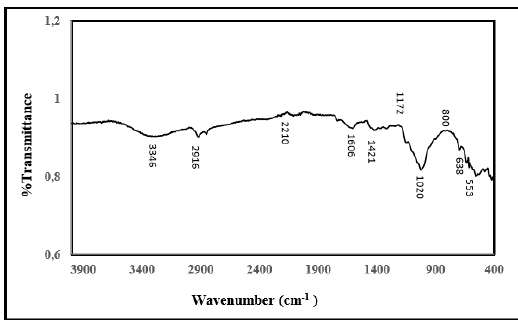
Figure 7. FT-IR spectrum of modified lily flower with nano magnetite and purified pectin lyase immobilized modified lily flower with nano magnetite.